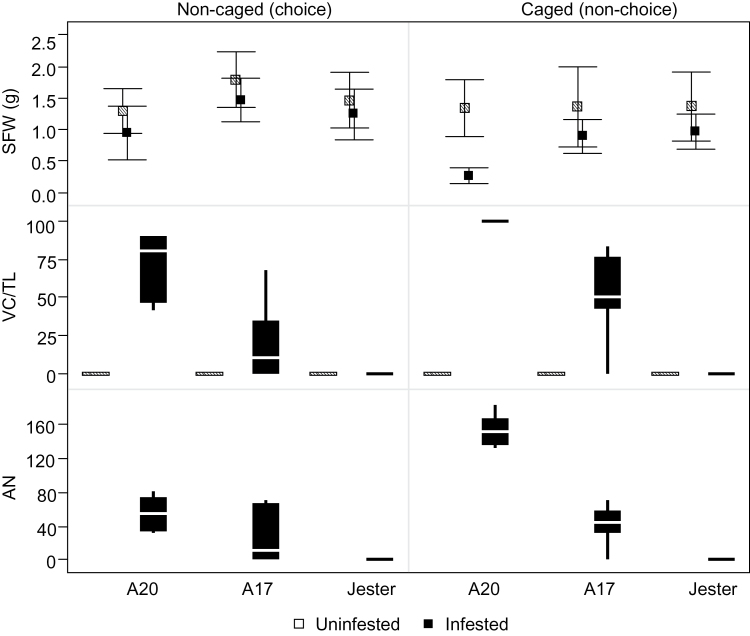

M. truncatula response to SAA infestation measured as SFW, as the proportion of leaves showing VC (VC/TL), or total AN per plant at 17 dpi. SFW values are represented by means (black, infested; hatched, non-infested controls); error bars are 95% confidence intervals around the mean. VC/TL and AN values are represented by outlier box plots (the box represents the distribution of half of the observations, the horizontal white line is the median, and the whiskers are the lower and upper quartiles). For each experiment there were six to eight experimental units.